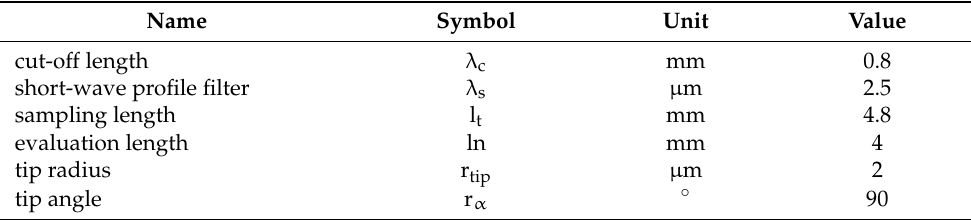
Table 1. Measurement conditions for the detection of the surface roughness.